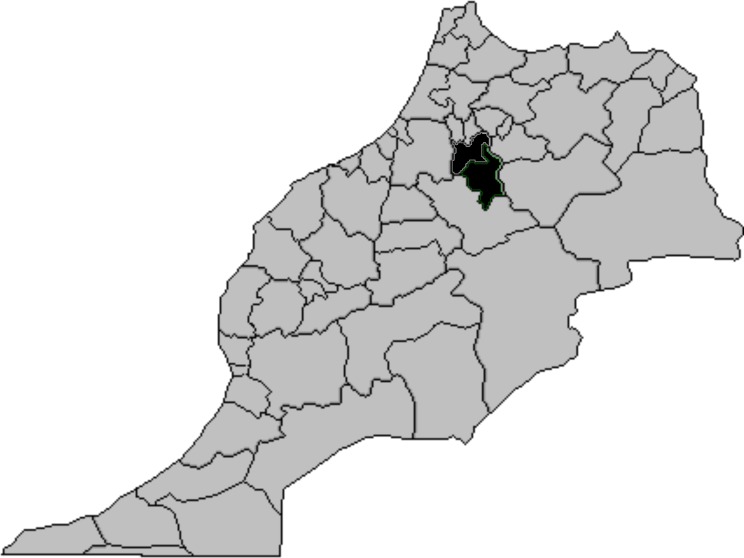
Map of Morocco and the survey area.The survey area is indicated in black. This includes the rural communes of Timahdit and Ain Louh in the province of Ifrane, and the rural communes of Bouderbala and Sebt Jehjouh in the province of El Hajeb, Meknes-Tafilalet region (designated as such until December 2014). Modified from Di Hanhil [Public Domani] Wikimedia Commons.